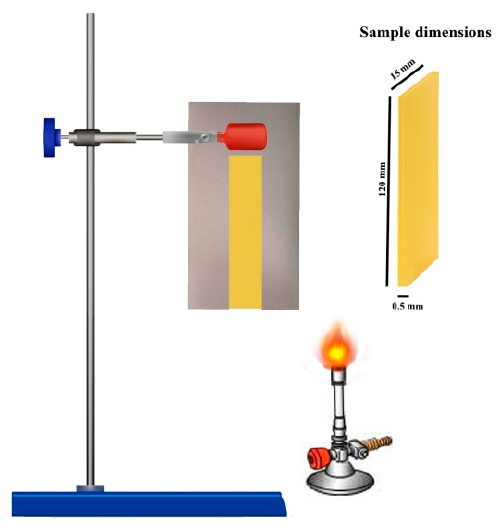
Figure 8. Illustration of flame test Set-up.